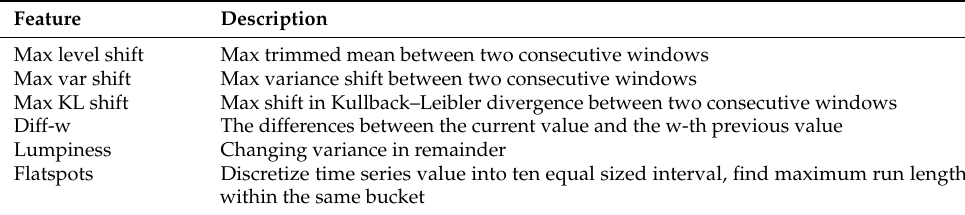
Table A4. Temporal features set (based on Table 3 in